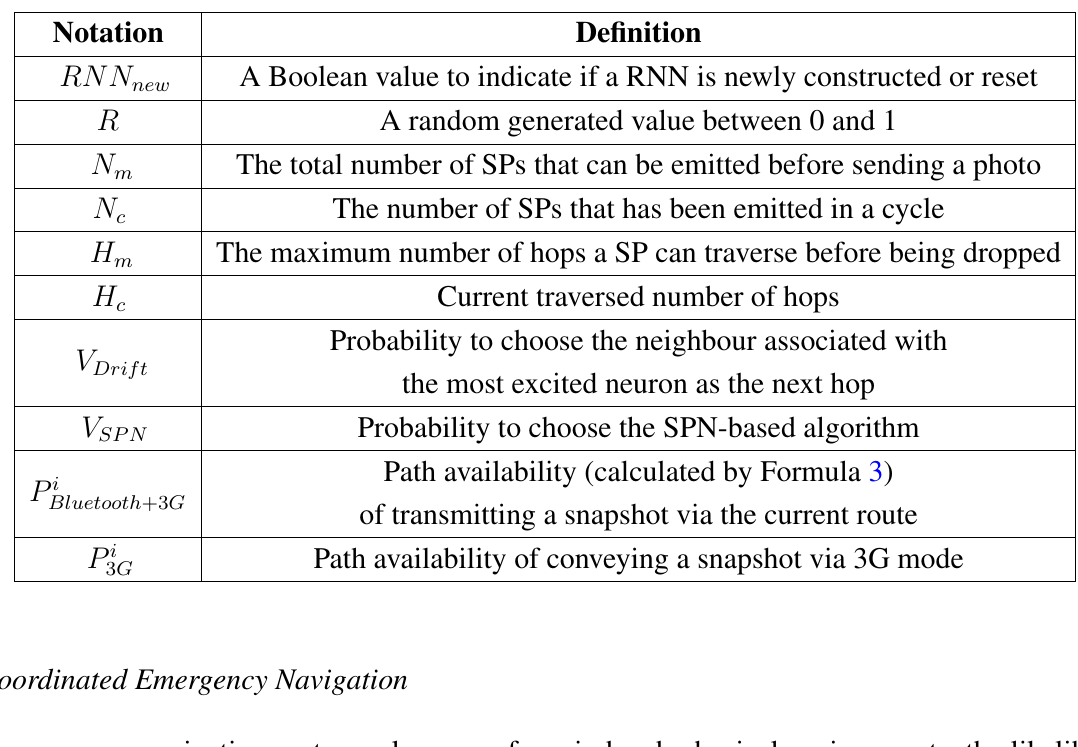
Table 2. List of symbols used in the Pseudocode 2. SP, smart